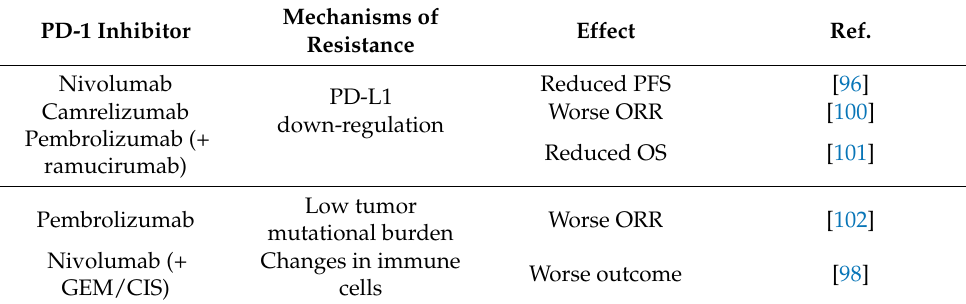
Table 3. MPRs to immunotherapy in